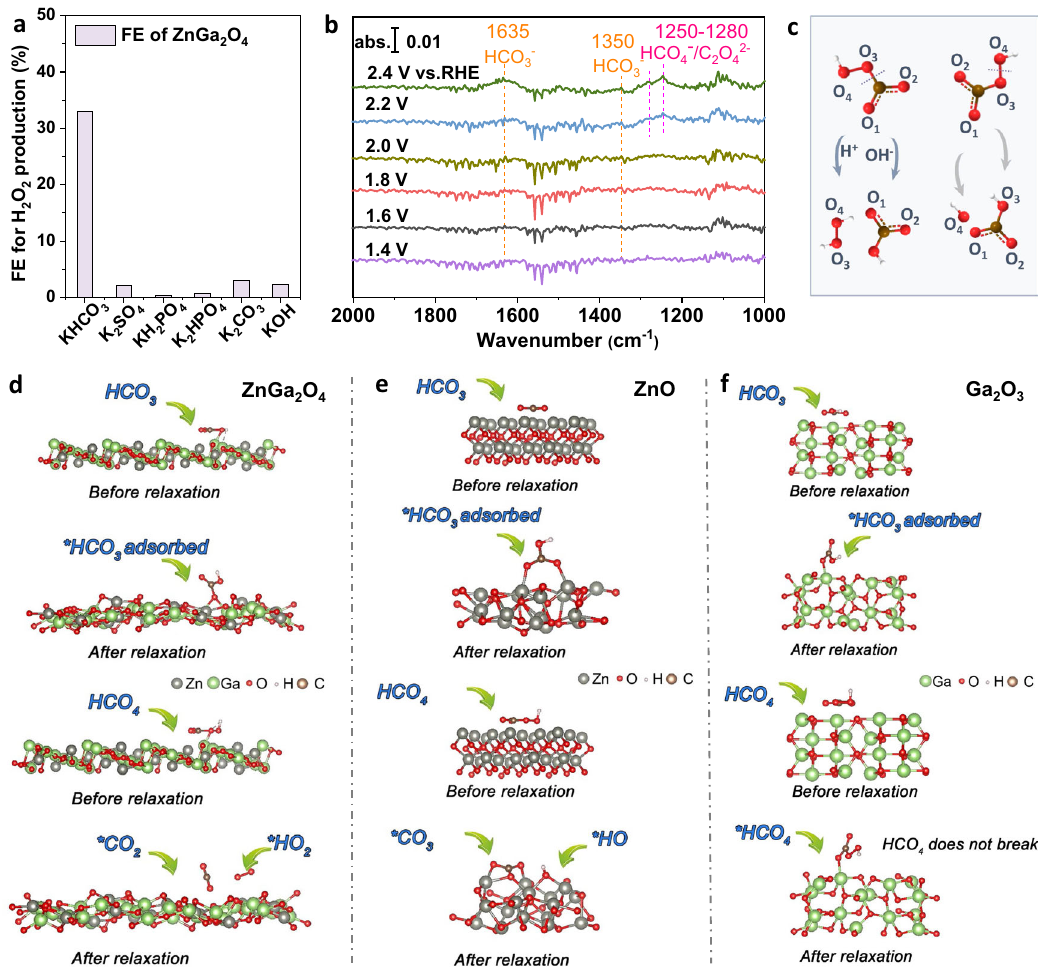
Fig. 4 | The bicarbonate species-mediated reaction pathway. a The H 2 O 2 FE of ZnGa 2 O 4 anode in different electrolytes(0.5M) ata constant current of 8mAcm − 2 . b InsituFouriertransforminfraredspectraofZnGa 2 O 4 atdifferentpotentialsin2M